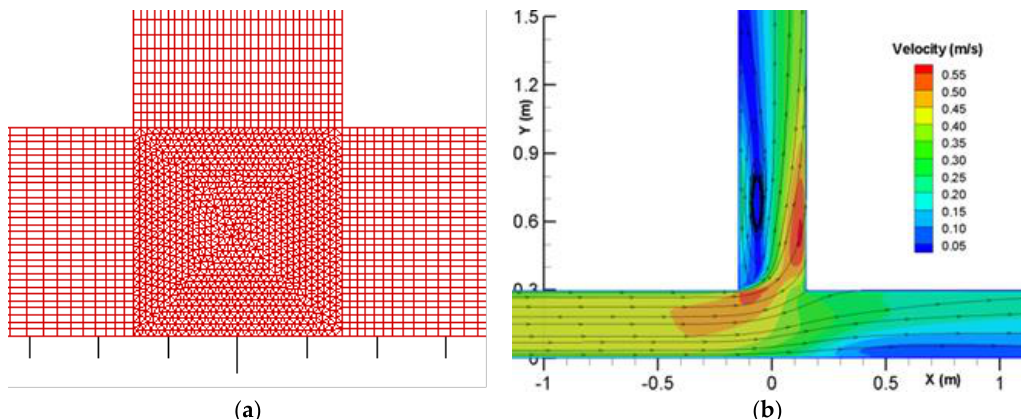
Figure 1. A portion of the mixed mesh at the juncture ( a ) and the predicted surface flow velocity for the flow diversion case ( b ).